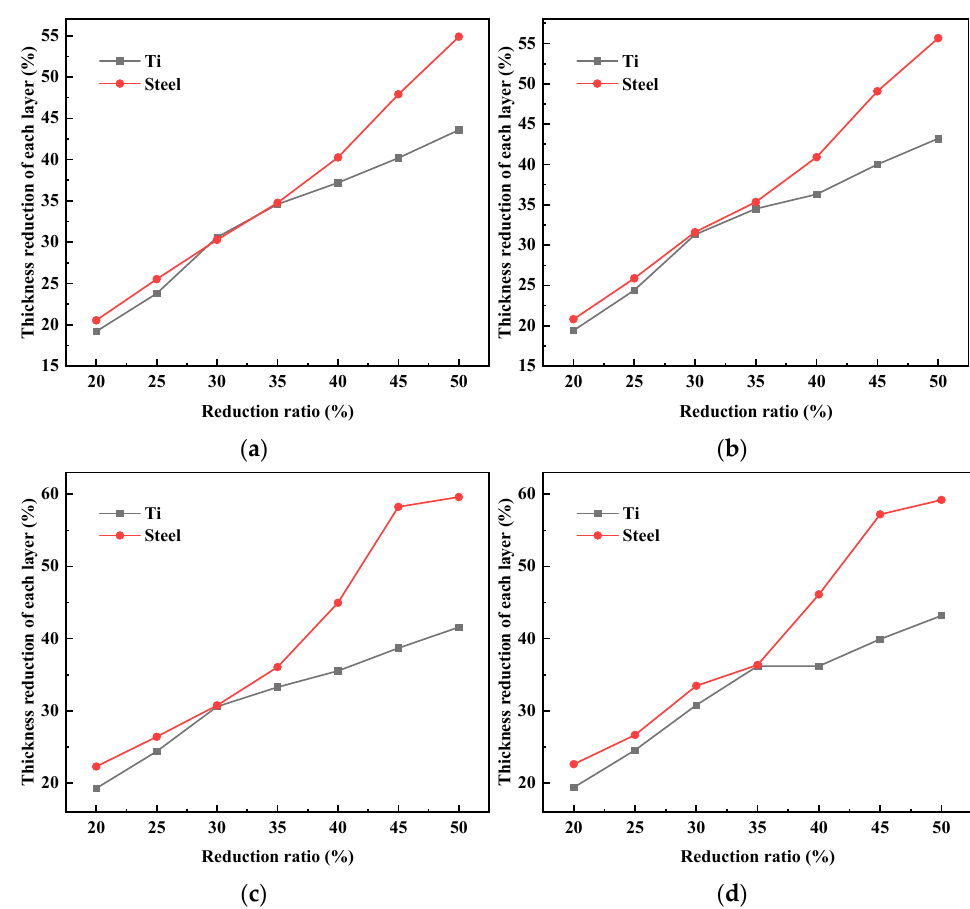
Figure 8. Difference between the thickness reductions of Ti and Steel. ( a ) Thickness ratio = 0.11, ( b ) thickness ratio = 0.25, ( c ) thickness ratio = 0.67, ( d ) thickness ratio = 1.0.